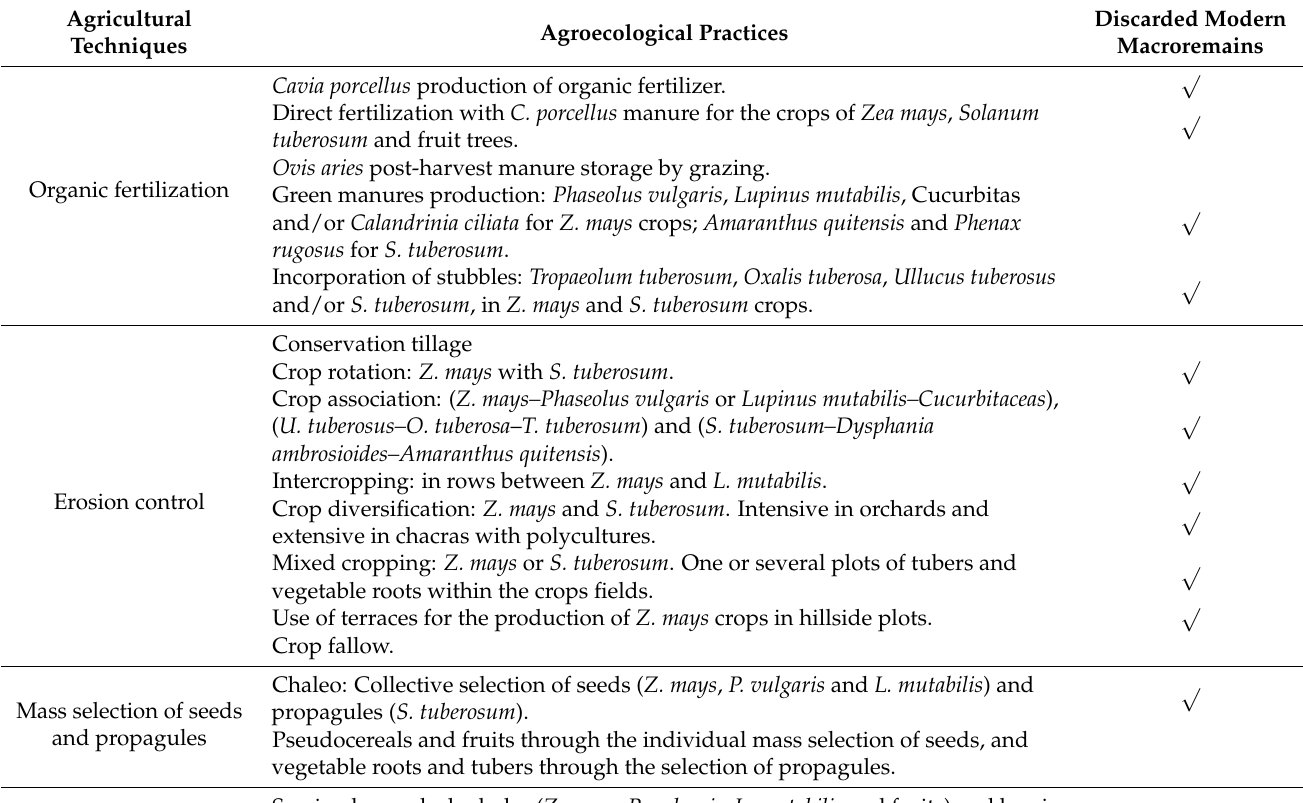
Table 4. Agroecological practices and modern macroremains assemblages recorded in the cropping systems of the Nizag